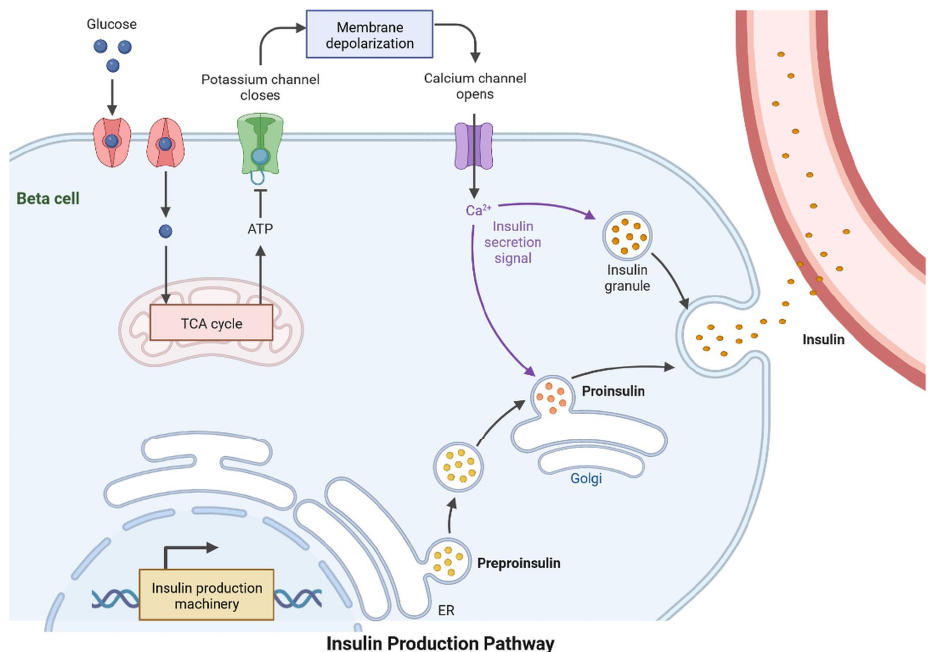
Figure 2. Regulation of blood glucose occurs through insulin.